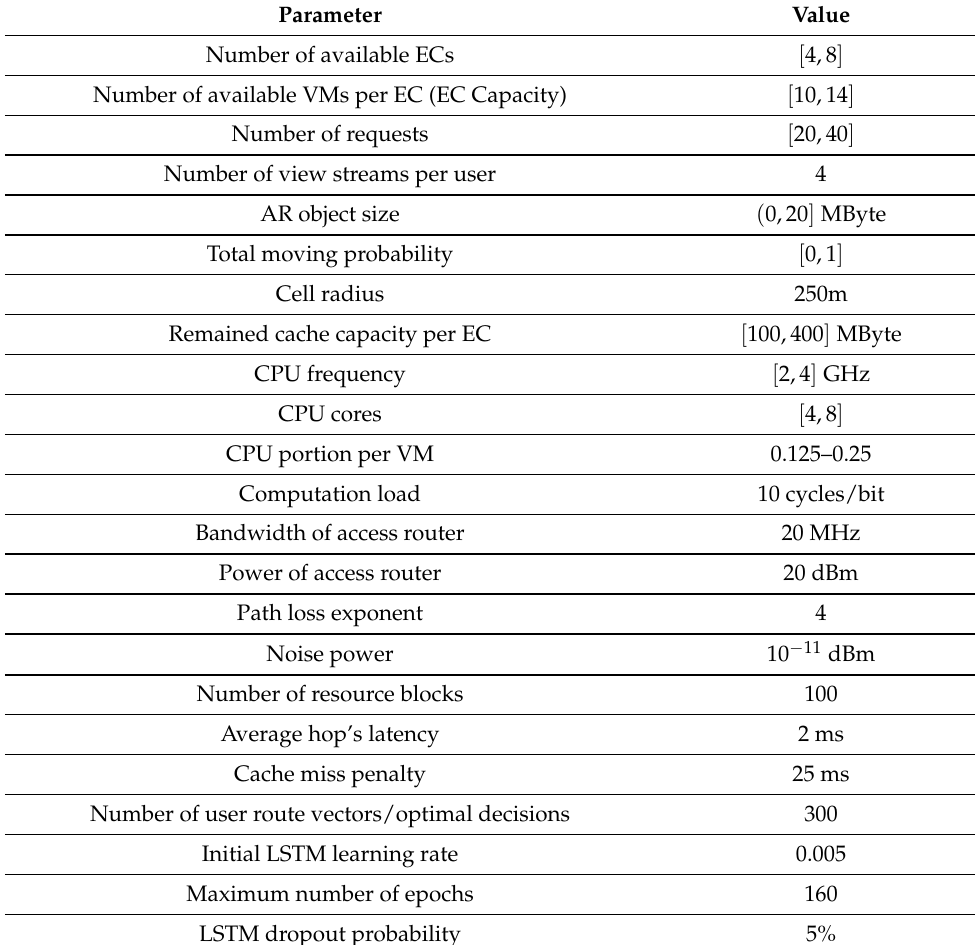
Table 2. Simulation